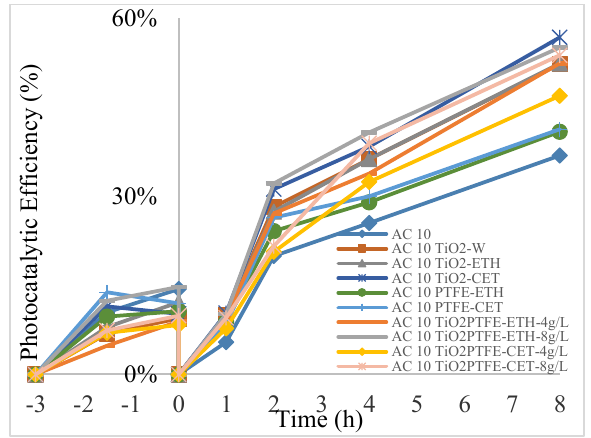
Fig. 1. Photocatalytic efficiency